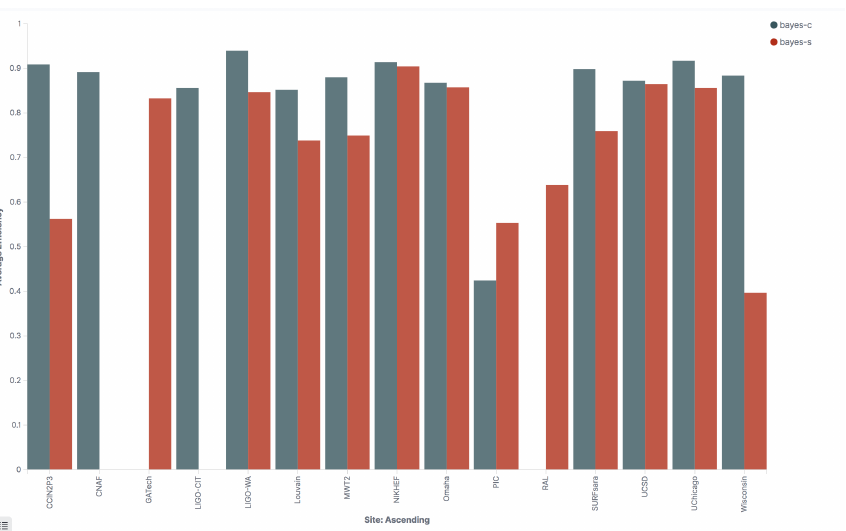
Figure 10. Benchmark Monitoring of job e ffi ciencies across IGWN compute sites. Shown here is the average job e ffi ciency across sites for two Bayeswave benchmarks: Code deployed through a conda- python virtual environment (bayes-c) and code deployed through a Singularity container